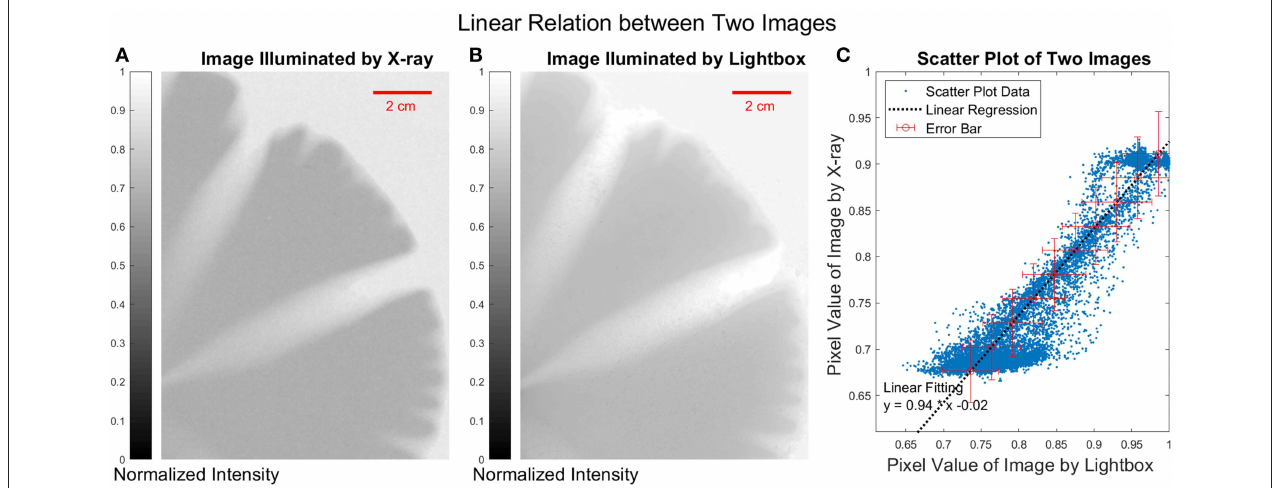
FIGURE 6 | (A) X-ray image of the plaster sample. (B) Image illuminated by light box of the white light. (C) The scatter plot, each point in the scatter plot represents a pixel at the same position in both images illuminated by X-ray and the white light. The error bars are of the order of 5 % on each of the axes. The pixel value below 0.7 represents the undissolved part and the pixel value above 0.9 represents the empty area outside of the plaster sample.